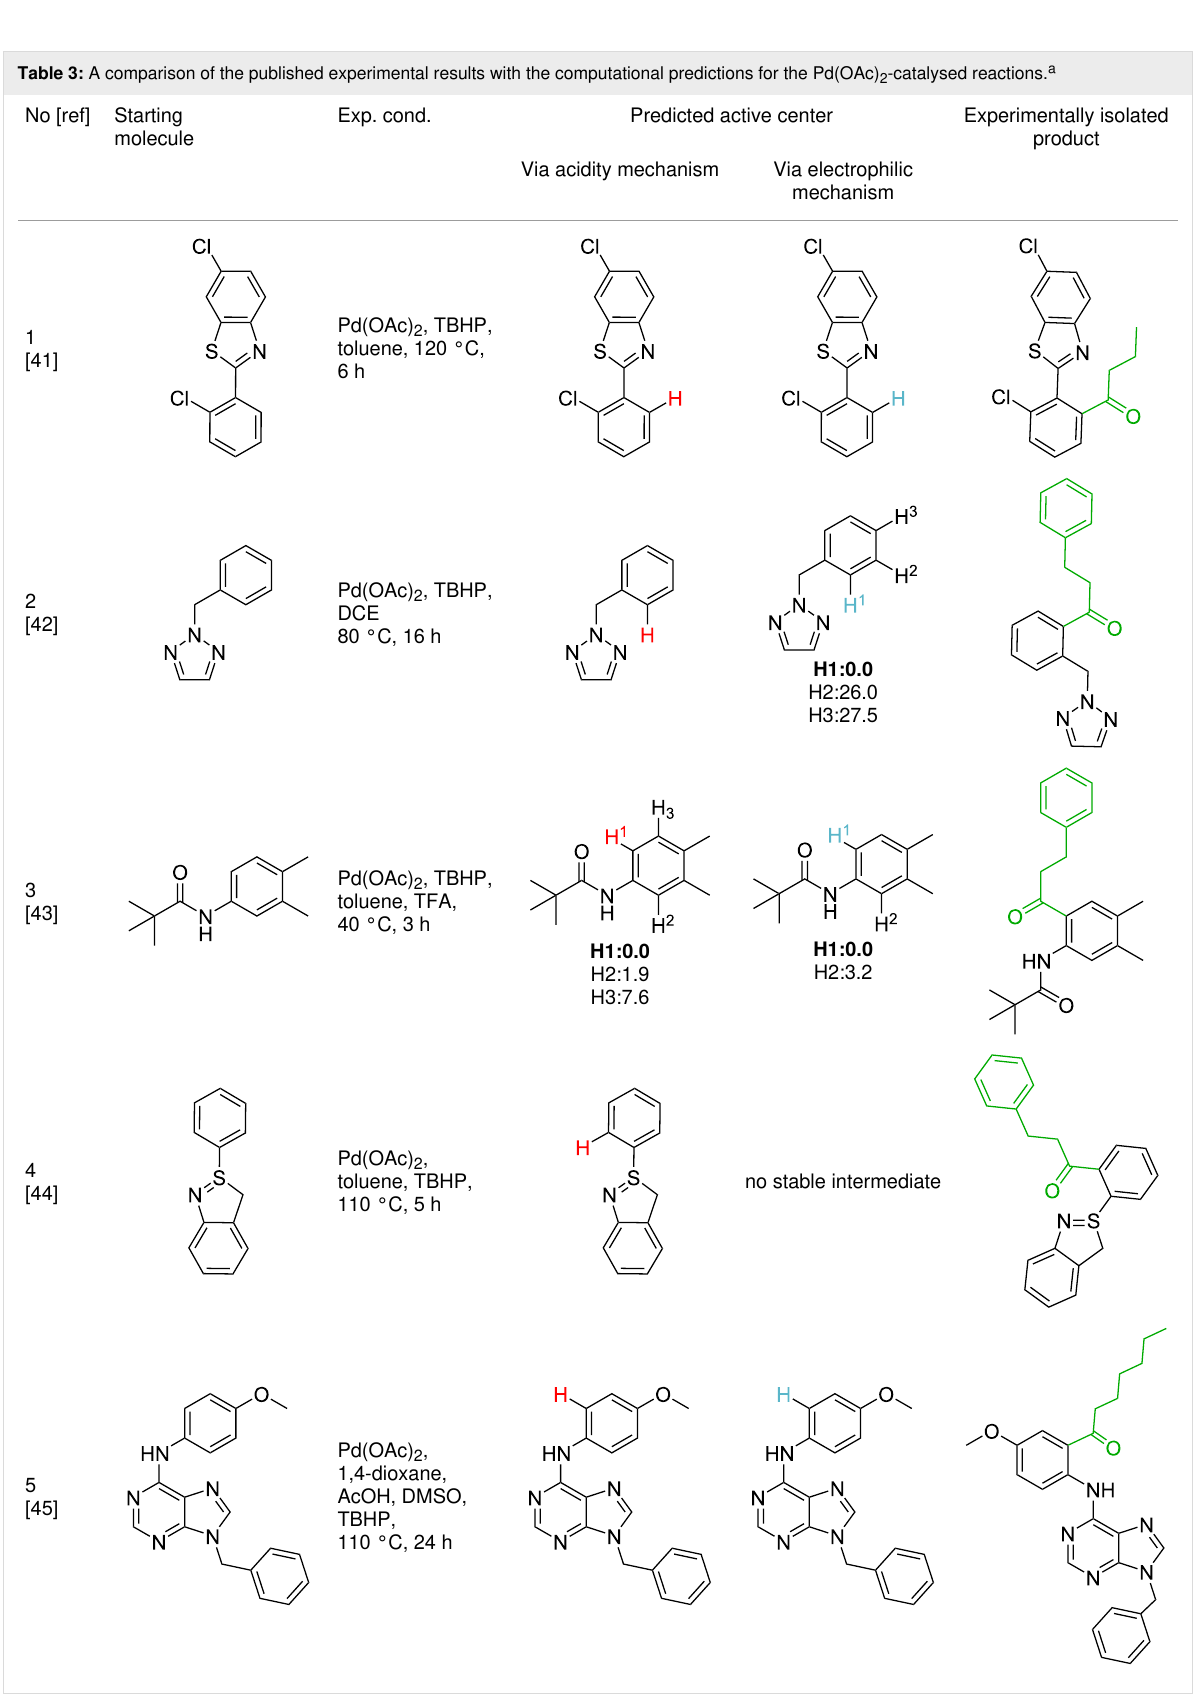
Table 3: A comparison of the published experimental results with the computational predictions for the Pd(OAc) 2 -catalysed reactions. a